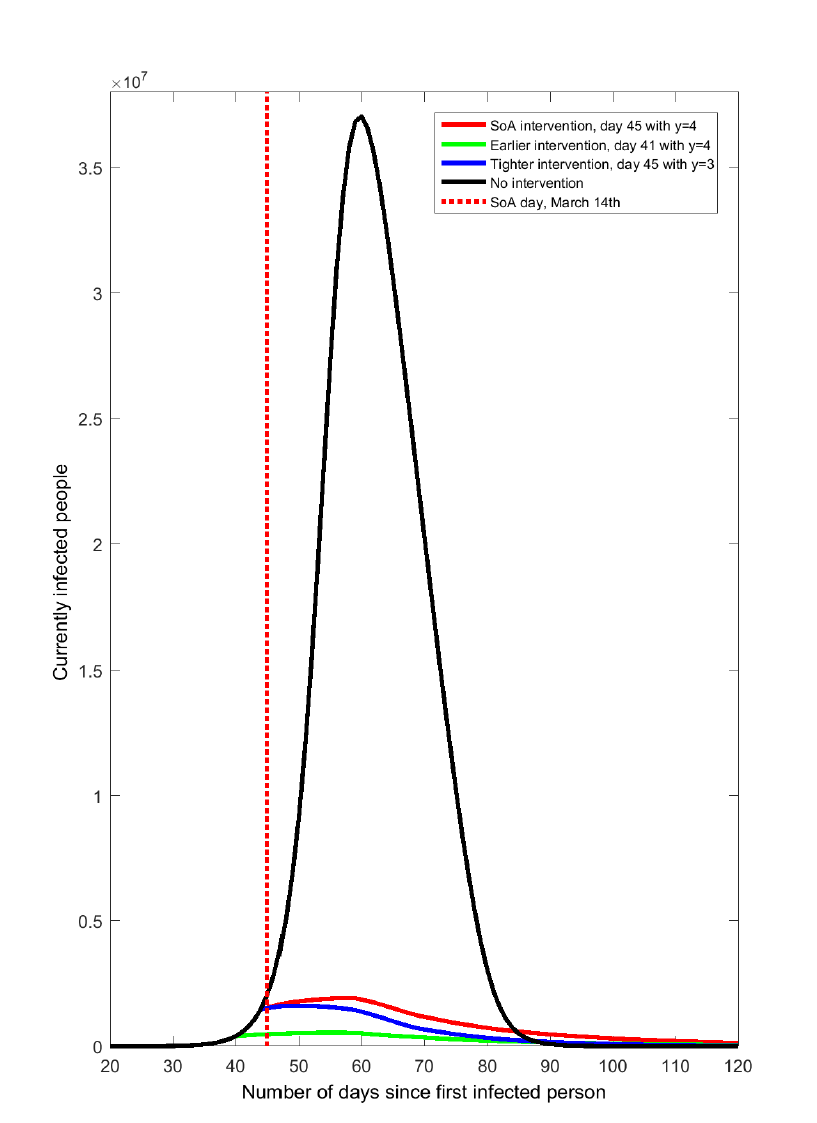
Figure A1. COVID-19 contagion spread in Spain after the end of the state of